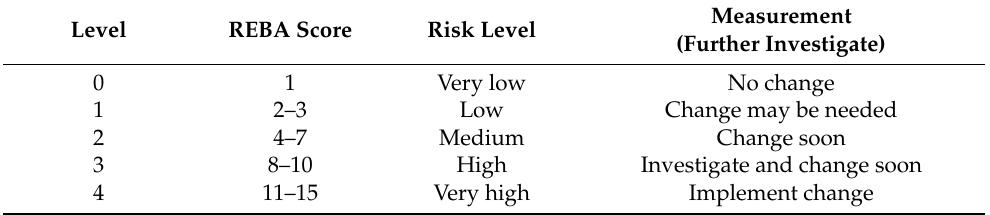
Table 16. REBA decision-making